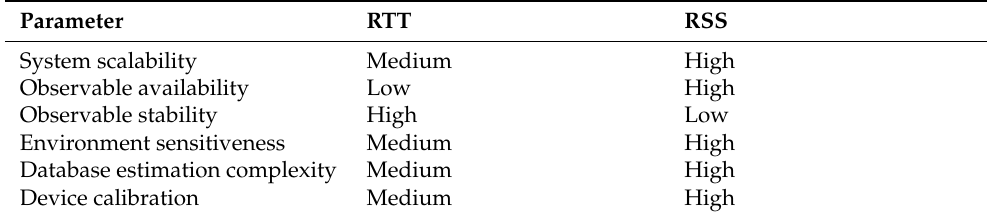
Table 1. Properties of RTT and RSS as observables for fingerprint-based positioning.